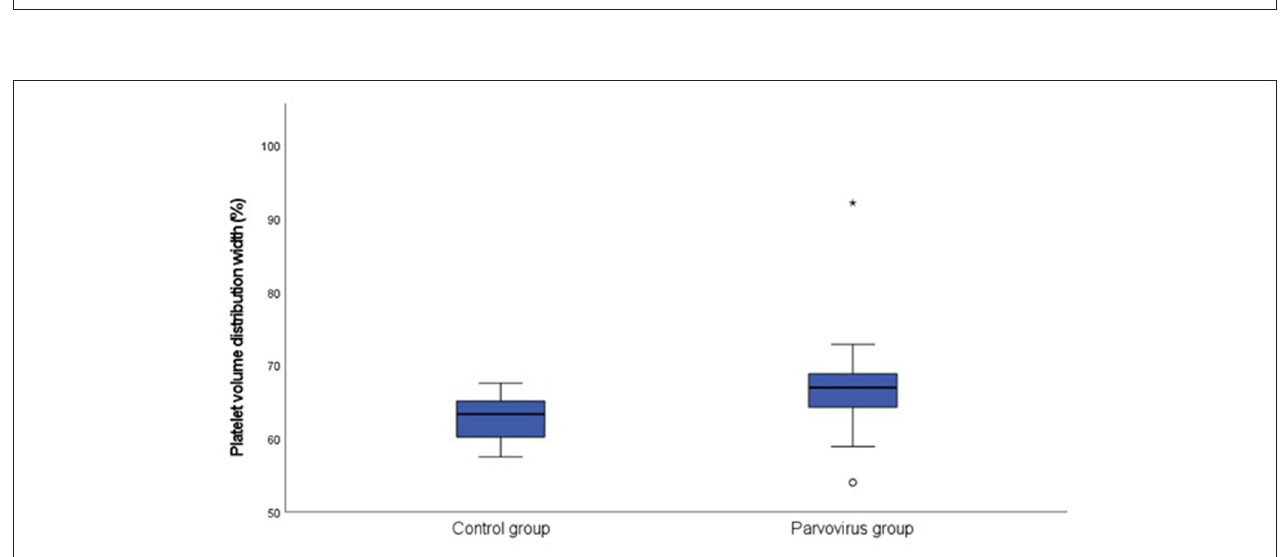
FIGURE 2 | Box plot of the admission PVDW of the CPV infected group ( N = 48) compared to the healthy control group ( N = 18). All values below the 10 th percentile and above the 90 th percentile are plotted separately as dots and the